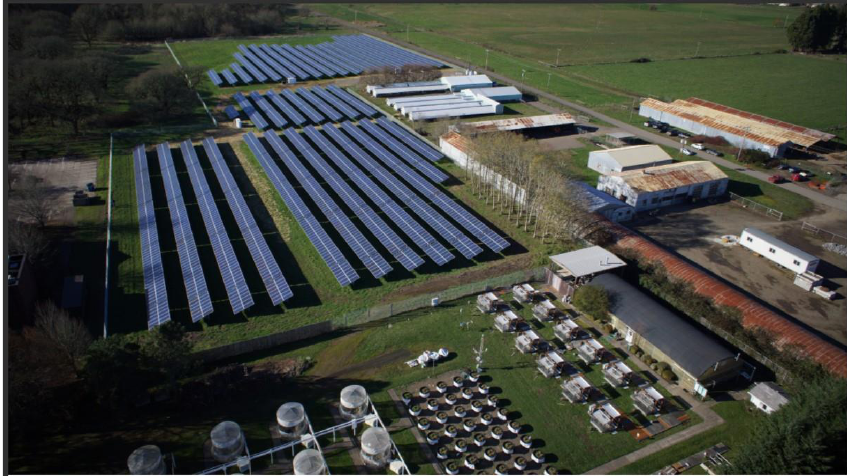
Figure 8. Rabbit Hill site set-up for micro-climate observation Source: [34].